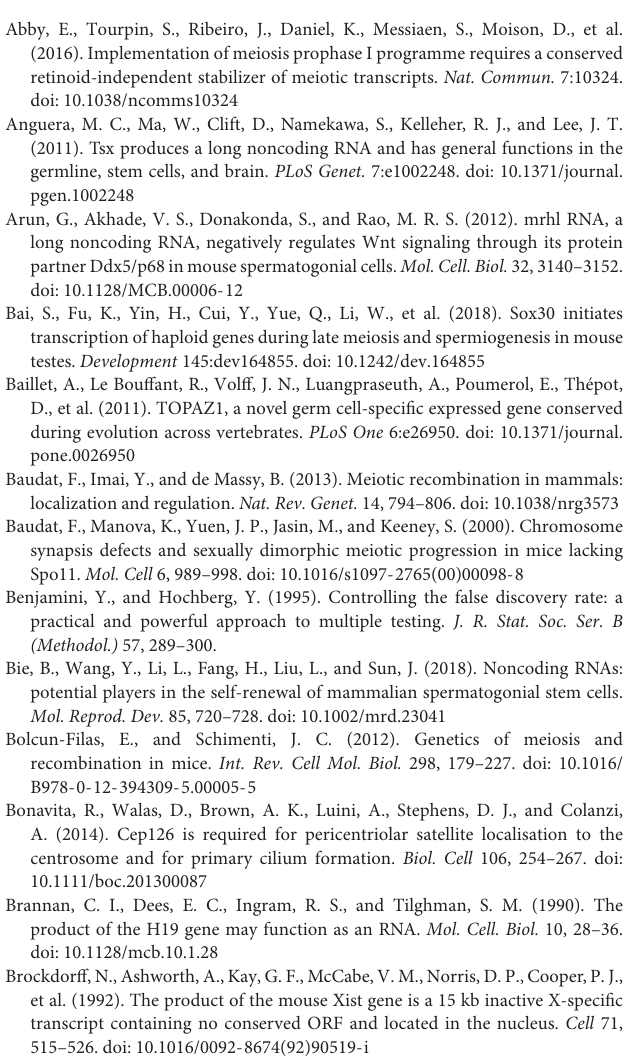
Supplementary Figure 10 | Validation of several DEGs by RT-qPCR (RNA-seq 4930463O16Rik − / − vs. WT testes). Validation of several differentially expressed Supplementary Table 1 | List of primers. List of different primers used during this study for genotyping, RT-qPCR and gRNAs. Supplementary Table 2 | Casa system settings. Supplementary Table 3 | List of DEGs in Topaz1 − / − testes compared to WT. List of deregulated genes in Topaz1 KO testes at P16 (sheet 1) and P18 (sheet 2) (adjusted p -value < 0.05 and absolute Log2FC > 1). Supplementary Table 4 | Functional annotation of P16 DEGs (RNA-seq Topaz1 − / − vs. WT testes). DAVID functional Annotation Clustering (DAVID 6.8)